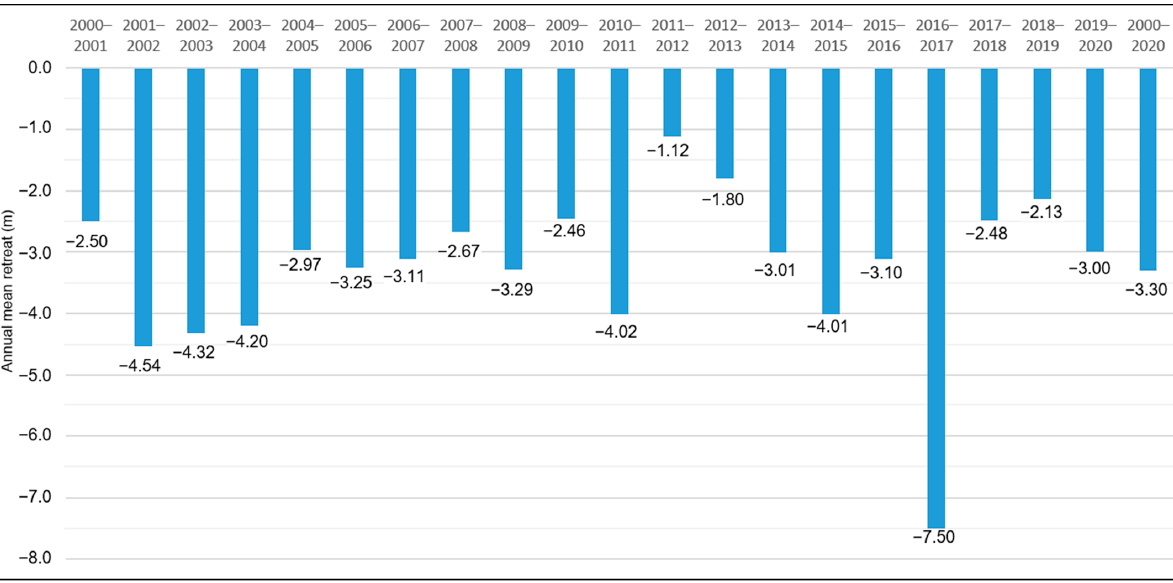
Figure 6. Annual mean retreat values (2000–2020).